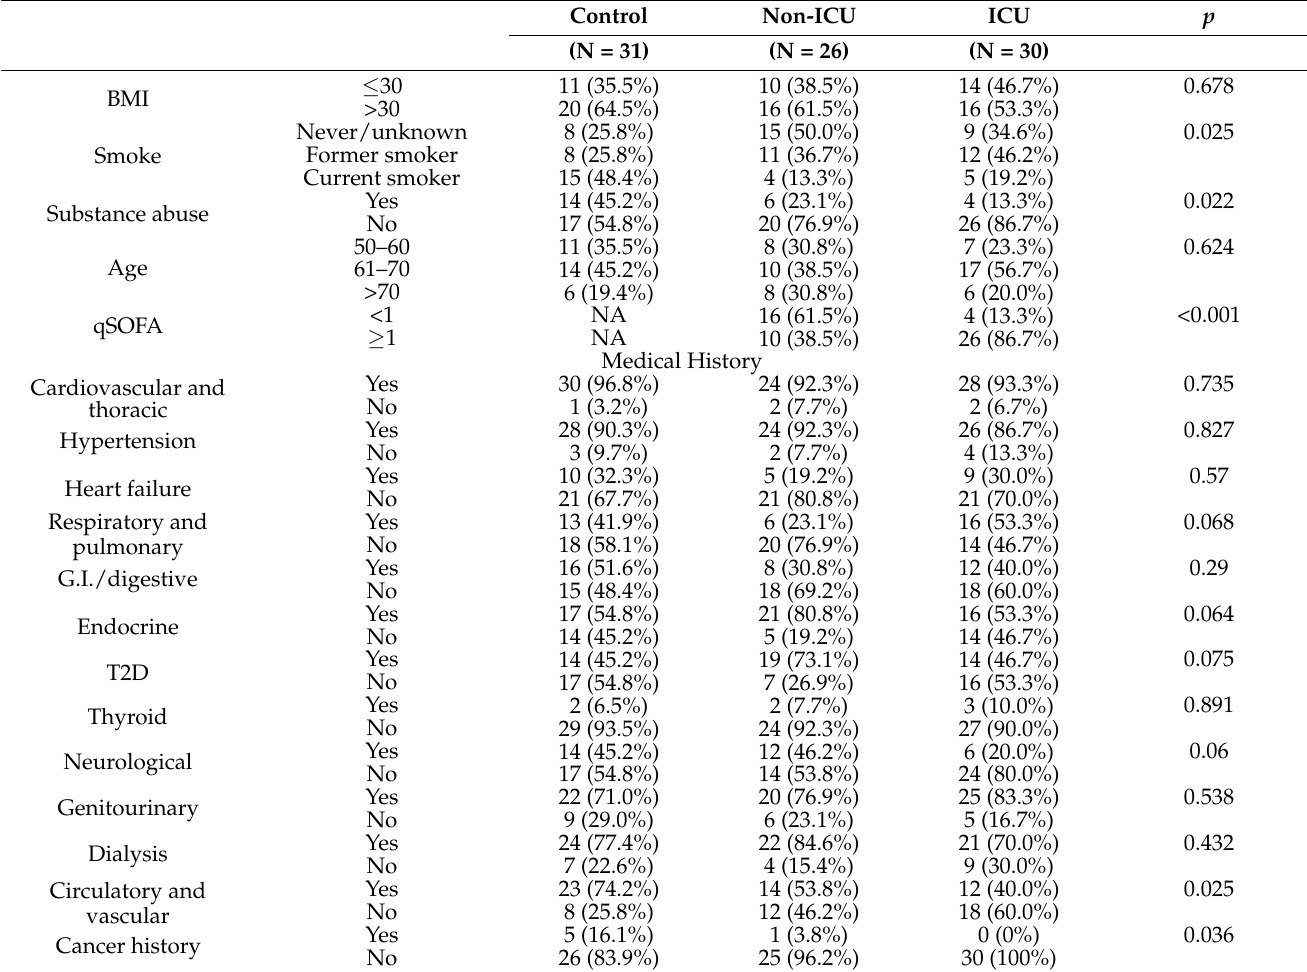
Table 1. Study participant characteristics by COVID-19